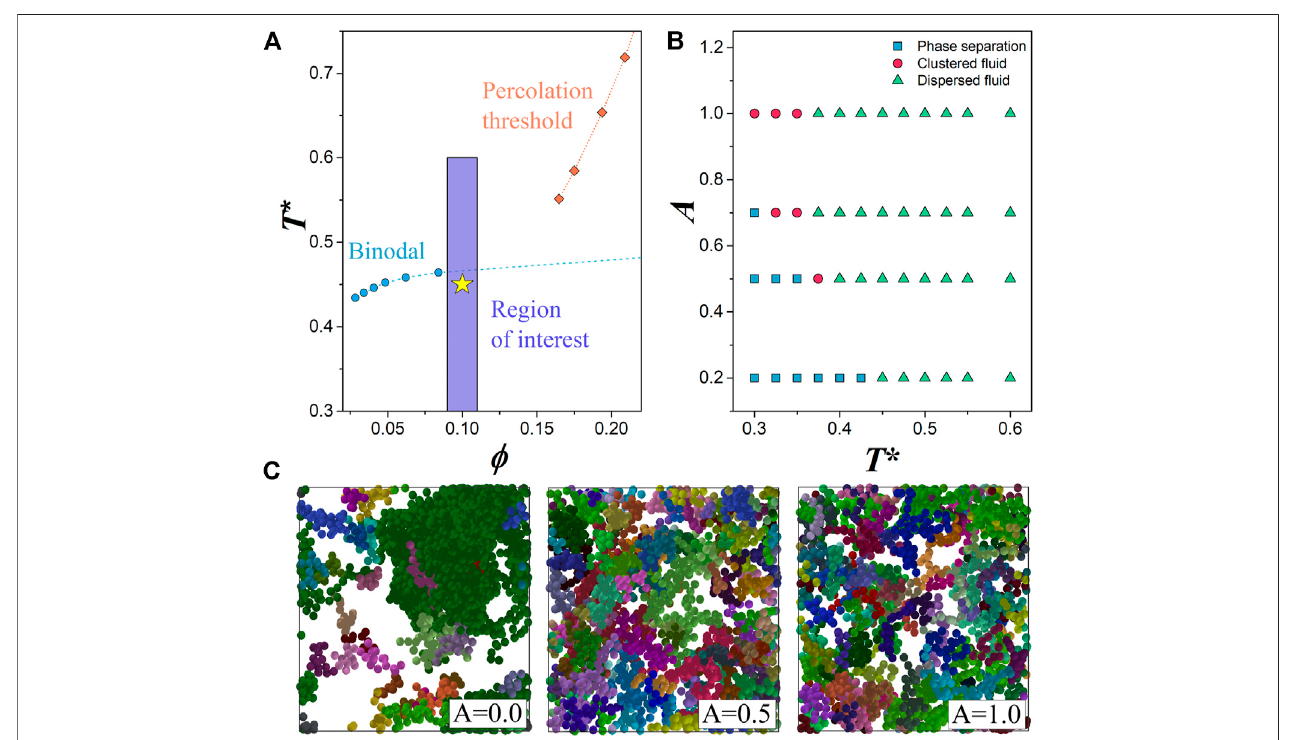
FIGURE3|(A) phasediagramfortheSW fl uidwith λ (cid:2) 1 . 1,ourreferencesystem.Circlescorrespondtothegas-liquidphaseseparationtakenfromreference[29]; diamonds point out the percolation threshold, from reference [33]; using the extended law of corresponding states to map the SW with λ (cid:2) 1 . 05 data. (B) State for particlesinteractingthroughthefullSALRpotential,hereweidentifythedispersed fl uid,theclustered fl uidandthosestatesinthephaseseparation,see Supplementary Material . (C) Snapshots correspondingtotheyellow starfordifferentrepulsion strengths. Clustersarecoloredrandomlytobeeasily identi fi ed. Forclarity,clusters with 10 or more particles are the only ones